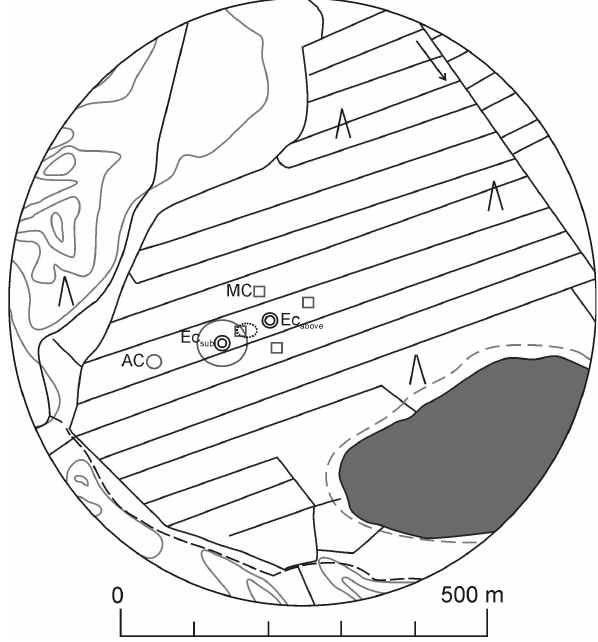
Fig. 1. Map of the measurement site showing the locations of above canopy eddy covariance (EC) mast (ECabove), sub-canopy EC mast (ECsub), manual chambers (MC, square) and automatic chambers (AC, circle). Dotted line next to one of the manual cham- ber groups show the place of soil gas concentration pits, and grey line around the sub-canopy EC mast show the footprint area from which 85% (at 30m) of the sub-canopy N 2 O fluxes originate (see Mammarella et al.,